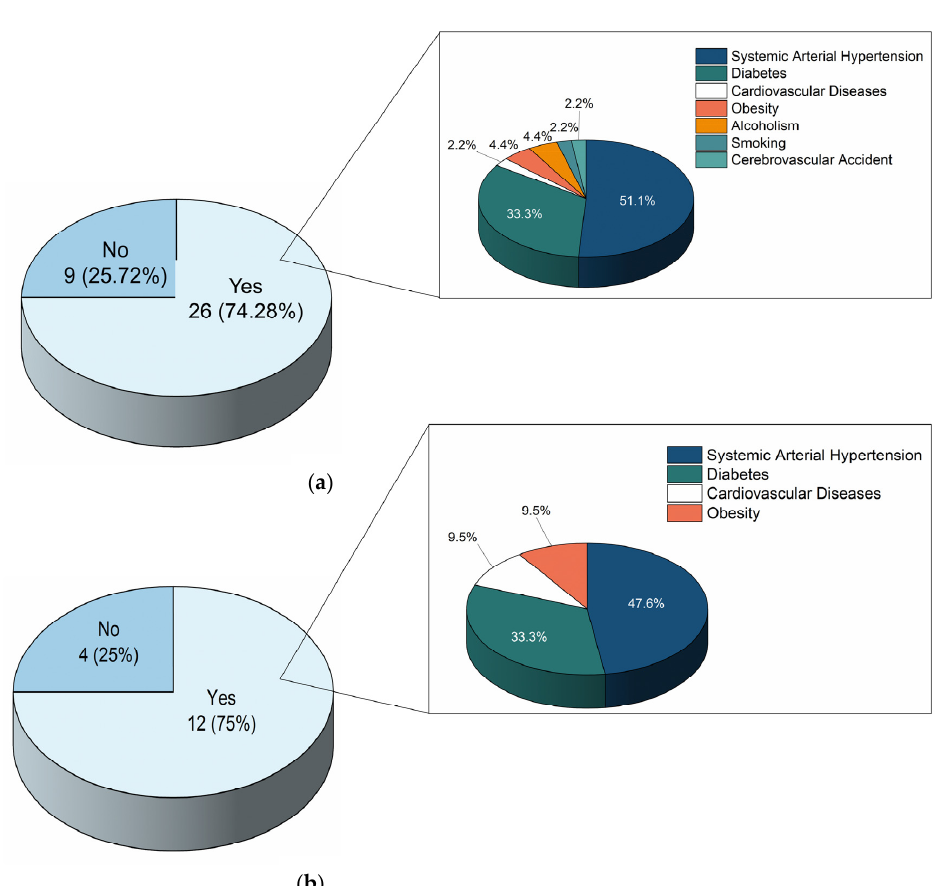
Figure 3. Comorbidity of study patients: ( a ) patients who remained with the device for 4 or 7 days and ( b ) patients who required invasive ventilation (intubation).